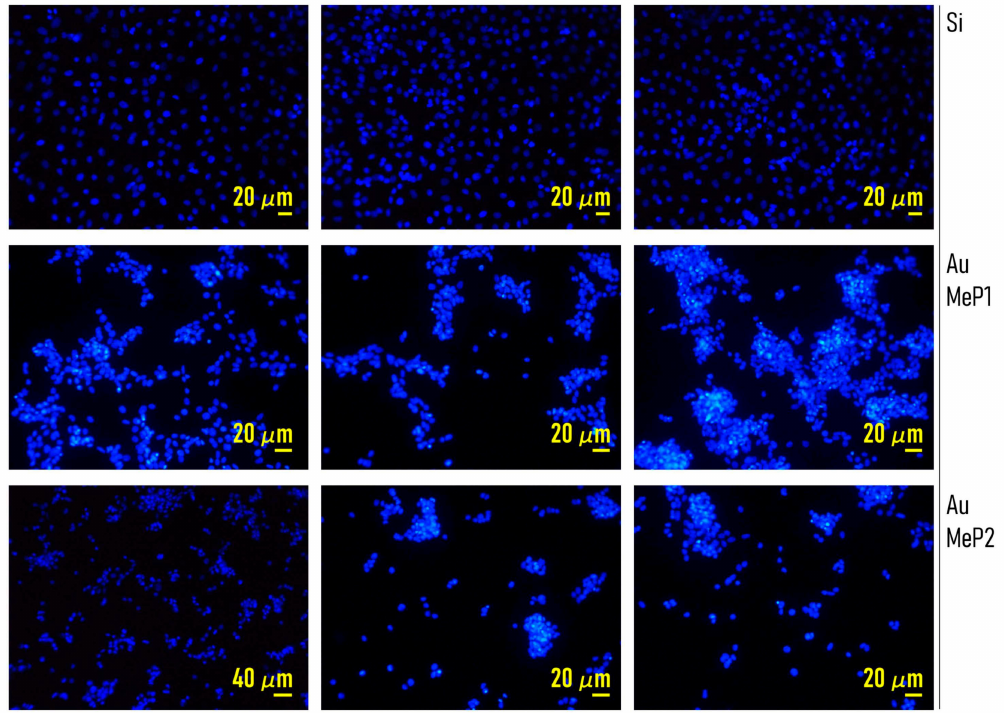
Figure 4. Fluorescence images of MCF-7 cancer cells over MeP 1 , MeP 2 , and silicon surfaces after 24 h from